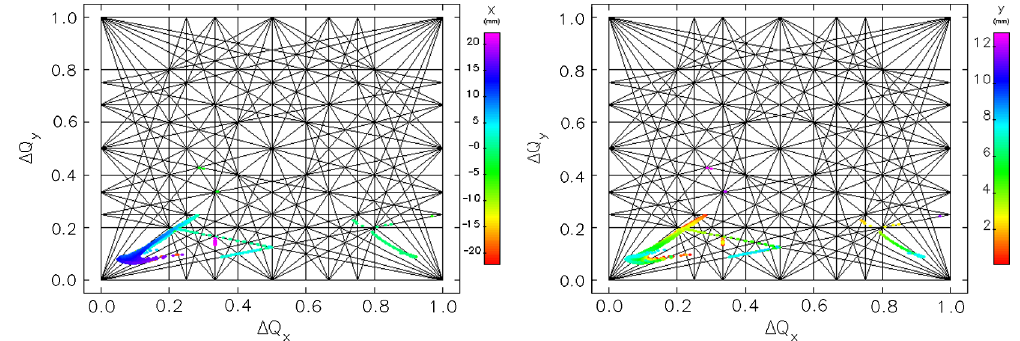
FIG. 7. Variation of the fraction of the tune point due to the amplitude in tune diagram with 5th order of resonance lines. The colors indicate (left) horizontal and (right) vertical